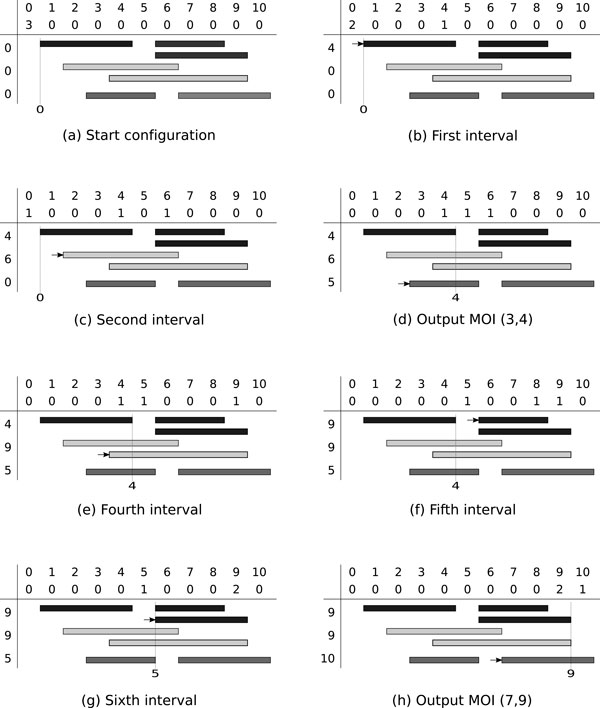
Example of algorithm LinearMOI. Example of algorithm LinearMOI with C1 = {(1, 4), (6, 8), (6, 9)} (dark gray), C2 = {(2, 6), (4, 9)} (light gray) and C3 = {(3, 5), (7, 10)} (medium gray). The left column shows the state of endPoint, c is shown above the intervals, and min is represented by the dotted vertical line. The arrow points to the interval currently processed. Output is (3, 4) in step (d) and (7, 9) in step (h).